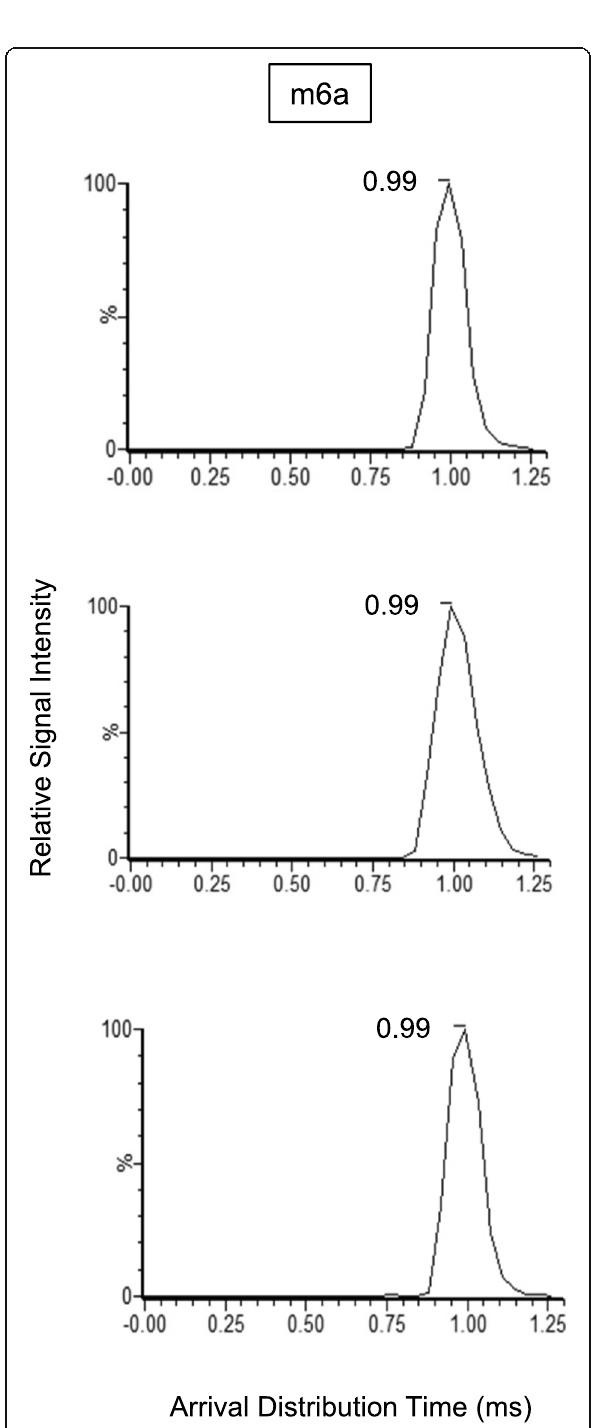
Fig. 3 Repeatability for acquiring the extracted ion mobility spectrum of